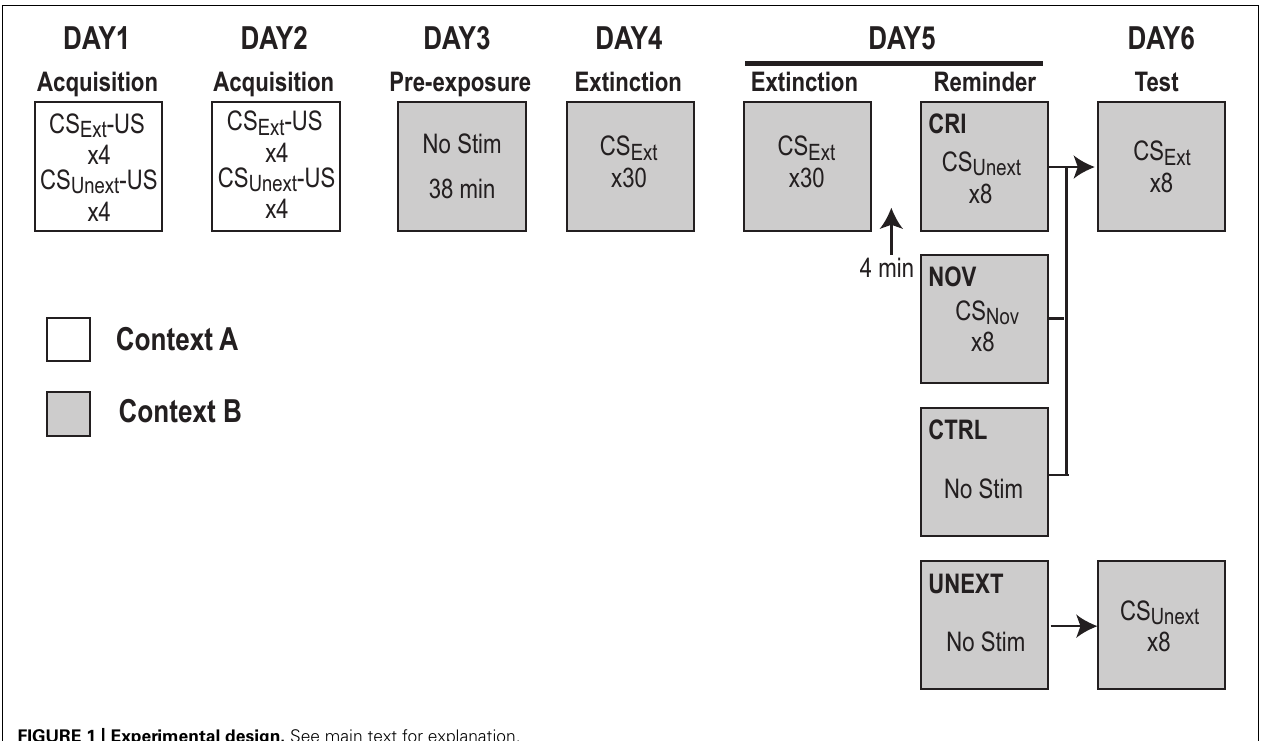
expected, freezing decreased across extinction trials. There was no main effect of group ( F 3,28 = 2.25, p = 0.104) or block × group interaction ( F 15,140 = 1.3, p = 0.21) on Day 2, indicating that by the end of extinction trials, all groups had similarly extinguished their responding to CS Ext